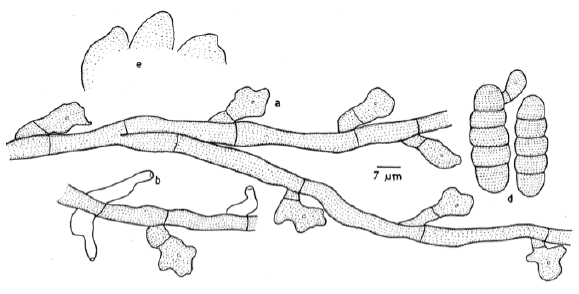
Figure 21. Asteridiella phaulopsidis a - Appressorium; b - Phialide; d - Ascospores; e - Perithecial wall